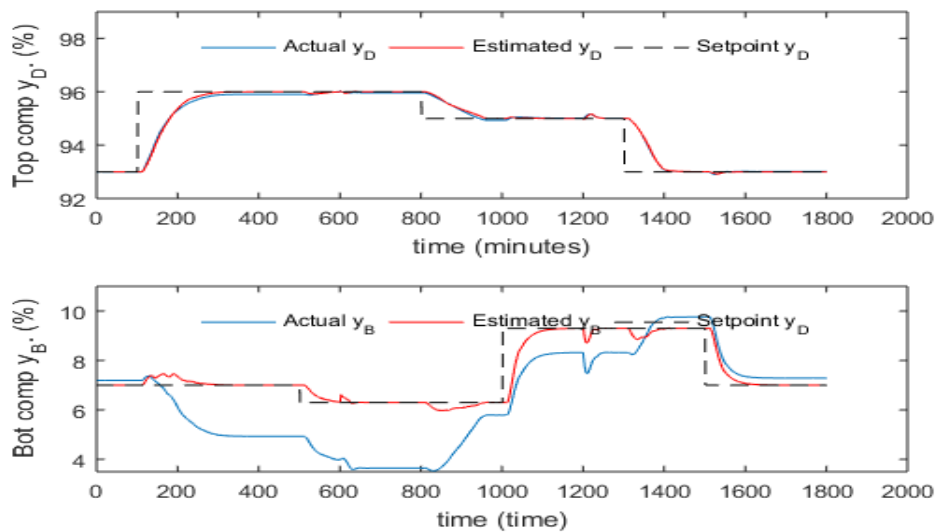
Figure 11. Responses of actual and estimated product compositions under inferential ADRC with static PCR model (without mean updating).